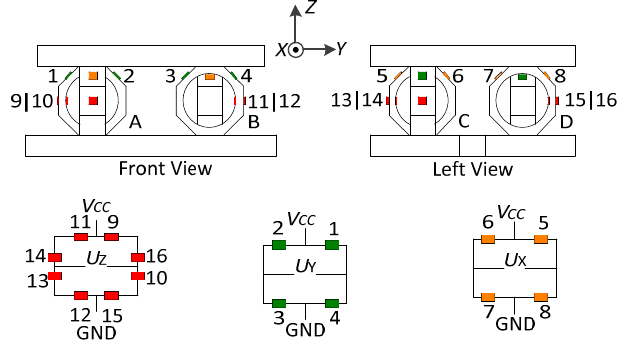
Figure A1. A diagram of the fixed force sensor.